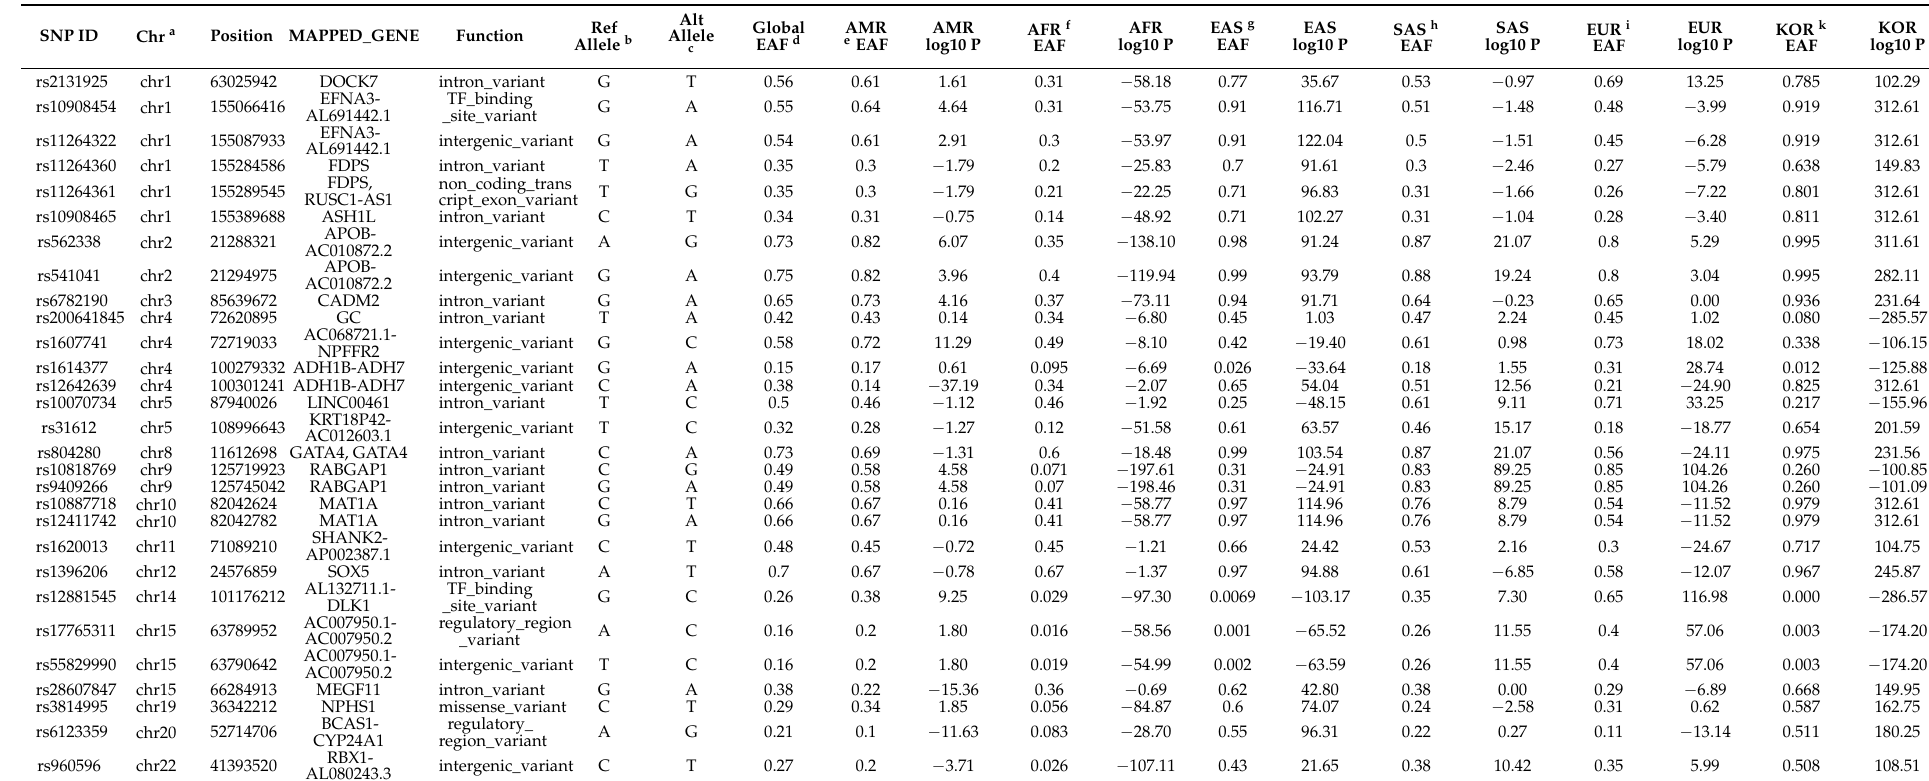
Table 1. Effect allele frequencies of vitamin D concentration-related single-nucleotide polymorphisms among continental